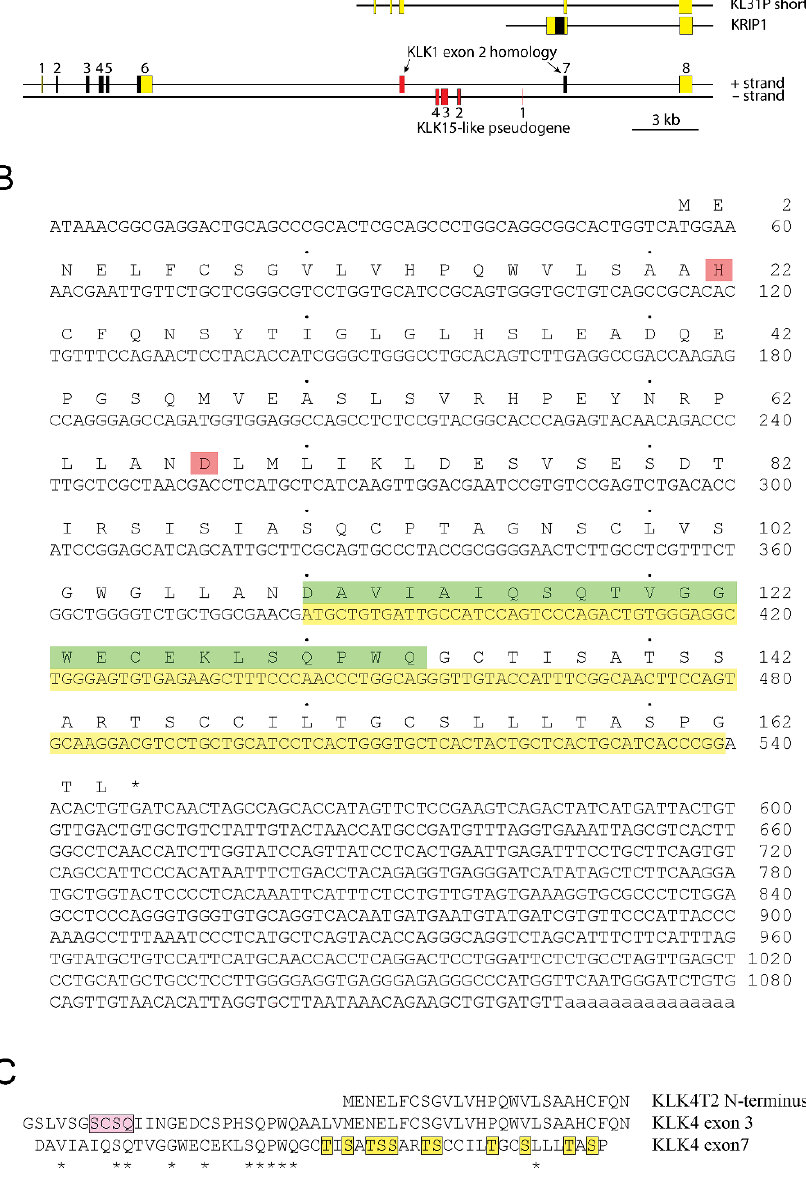
Figure 2. The extended KLK4 locus. ( A ) Schematic drawing of the KLK4 gene with location of previously reported KLKP1 genes illustrated above. Exons are indicated by boxes with translated sequences shown in black and nontranslated sequences in yellow. Exons of pseudogenes are colored in red. The new KLK4T2 transcript is formed by exon 4, 7, 8, and part of exon 3. ( B ) The cDNA sequence of KLK4T2 is shown with translation in one letter code written above. Stop codon is marked with an asterisk. The His and Asp part of the catalytic triad in KLK4 are marked in pink. Nucleotide sequence homologous to KLK1 exon 2 is highlighted in yellow, and the corresponding amino acid sequence until the frame shift, in green. ( C ) Conservation of amino acid residues encoded by exons 3 and 7 in KLK4. Amino acid alignments showing conserved residues encoded by KLK4 exon 3 and 7 indicated by stars. The pro-piece of proKLK4 is highlighted in pink and the Ser and Thr residues in the C-terminal part of the KLK4T2 product are highlighted in yellow. The N-terminal part of the KLK4T2 product is shown above the aligned sequences for